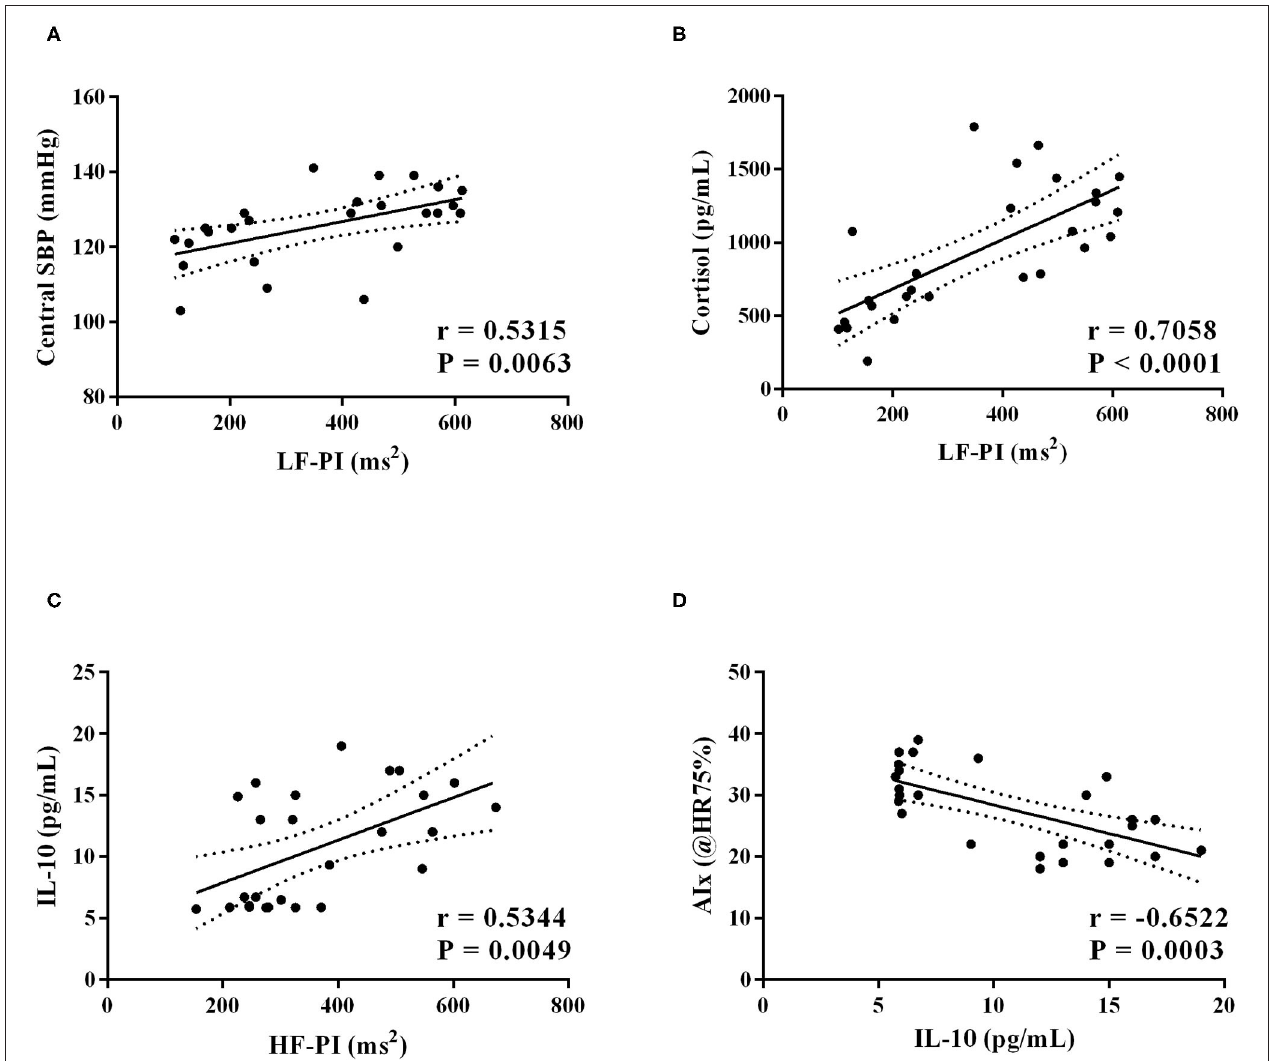
FIGURE 5 | Short-term intervention (10 sessions): Linear regression analysis was carried out and, if the slope of the regression line is significantly larger than 0 with P < 0.05, the linear regression (solid line) and its 95% confidence interval (dotted lines) are plotted as well. (A) LF-PI and Central SBP [r = 0.5315; P = 0.0063]; (B) LF-PI and Cortisol levels [r = 0.7058; P < 0.0001]; (C) HF-PI and IL-10 levels [r = 0.5344; P = 0.0049]; (D) IL-10 and AIx (@HR75%) [r = − 0.6522; P = 0.0003].